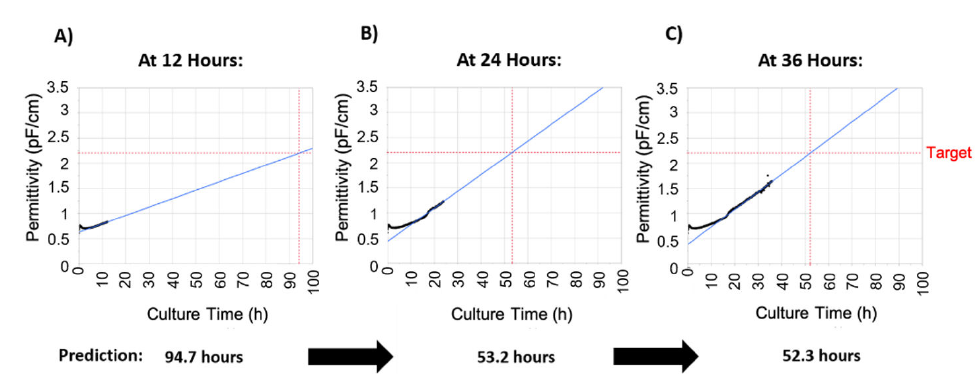
Figure 3. Outputs of the process-to-target. The script was run at di ff erent times after inoculation, and the infection timing predictions are indicated below each image. For this figure, batch 5 was used, in which the target was reached at 50.8 h. Permittivity data is represented in black, the blue line represents model predictions, and the red lines are the target (vertical axis) and the predicted time the target will be reached (horizontal axis). ( A ) Process-to-target script run 12 h after seeding. ( B ) Process-to-target script run 24 h after seeding. ( C ) Process-to-target script run 36 h after seeding.